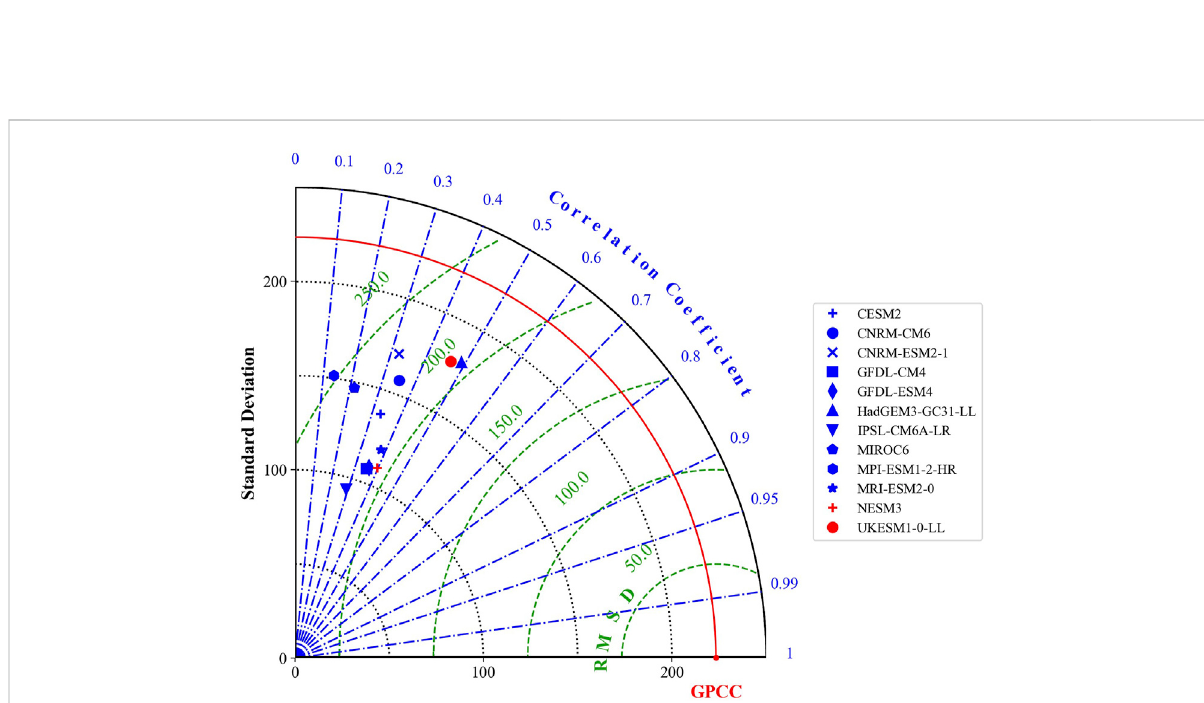
FIGURE 7 Taylor diagram comparing seasonal (MJJASO) PRE observation (GPCC) with models